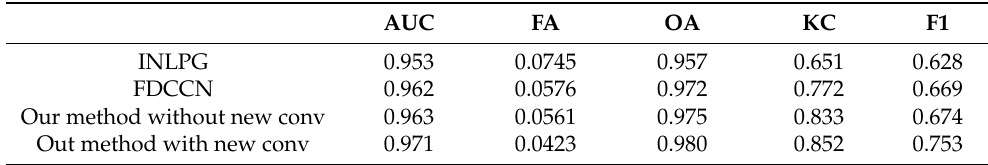
Table 4. The performance comparison for California between our proposed method and state-of-the- art